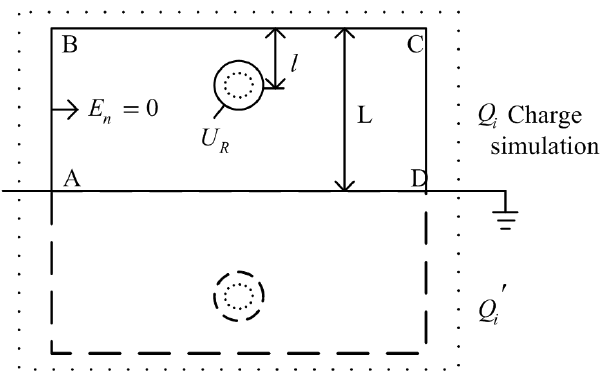
Figure 4. Schematic diagram of the charge simulation